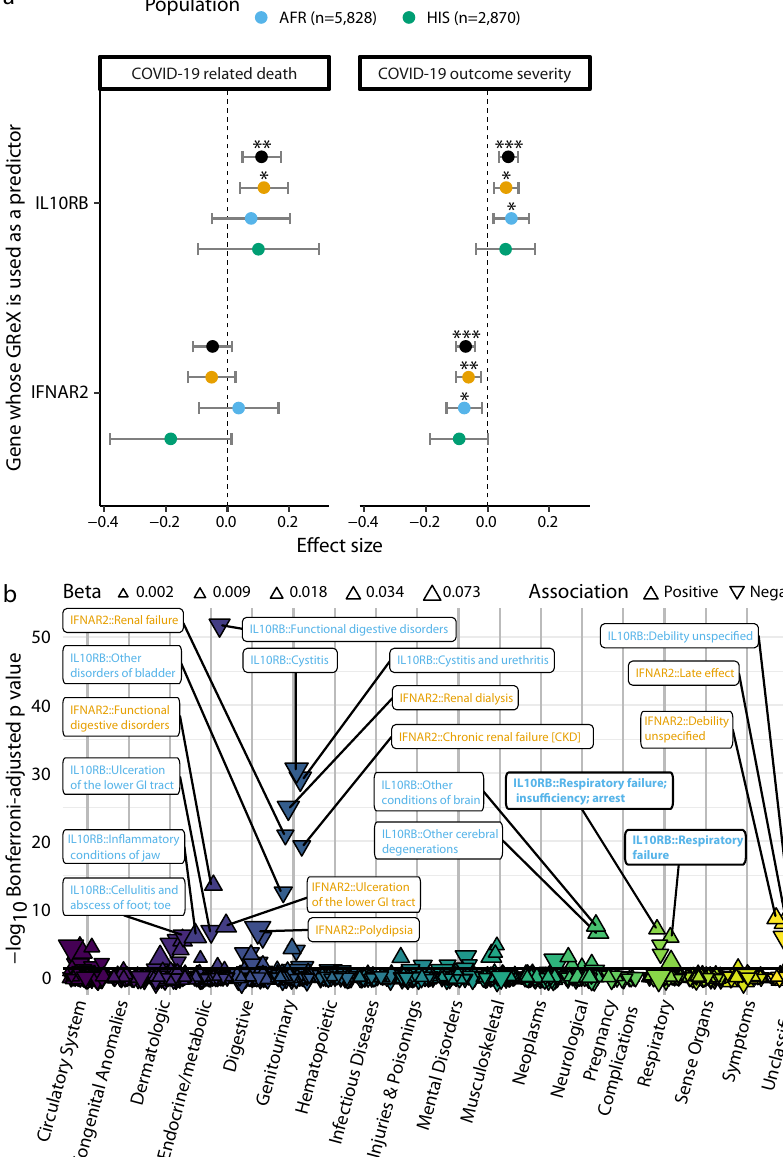
Fig. 3 Association of blood IL10RB and IFNAR2 genetically regulated gene expression (GReX) with COVID-19-related outcomes and non- COVID-19 phenotypes. a GReX of IL10RB and IFNAR2 was imputed in 23,216 individuals in the Million Veteran Program (MVP) cohort for whom COVID-19 outcome severity information was available. For COVID-19-related death (left panel) we checked the association of GReX with the outcome of COVID-19 related death (4.8% of this cohort) under logistic regression models for IL10RB and IFNAR2 GReX, while adjusting for age, sex, Elixhauser ’ s comorbidity score, and ancestry-speci fi c population structure. For COVID-19 outcome severity, we applied an ordinal regression model (same predictors and covariates as above) using an outcome scale corresponding to mild (74.9% of the cohort), moderate (17%), severe (3.2%) COVID-19 related outcomes, and death (4.8%). EUR, AFR, and HIS refer to harmonized European, African and Hispanic ancestry respectively and the sample sizes are provided in the legend at the top. For both panels, a population of Asian ancestry ( n = 266) was included in the fi xed effects meta-analysis (Population: “ ALL ” in the graph) but not plotted. ***, **, and * correspond to Bonferroni-adjusted association p -values (for n genes × n outcomes for each population cohort) of equal or less than 0.001, 0.01, and 0.05 respectively. Error bars show 95% CI. b Phenome-wide association study (PheWAS) of IL10RB and IFNAR2 blood GReX for individuals of European descent in the MVP cohort ( n = 296,407). Phenotypes are grouped in categories shown in the x -axis, while the y -axis represents − log 10 (Bonferroni-adjusted p -values). Triangles represent data points for positive (pointing up) and negative (pointing down) association with GReX; triangle size indicates the magnitude of the effect size and the color corresponds to the phenotype category. Only the top 20 associations are labeled (orange for IFNAR2 and blue for IL10RB ); full results are provided in Supplementary Data 9. The horizontal black line corresponds to Bonferroni-adjusted p =